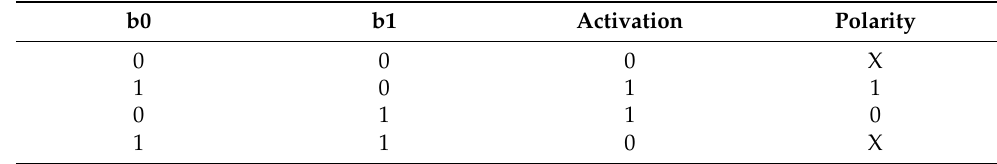
Table 3. Truth table and polarity for switching